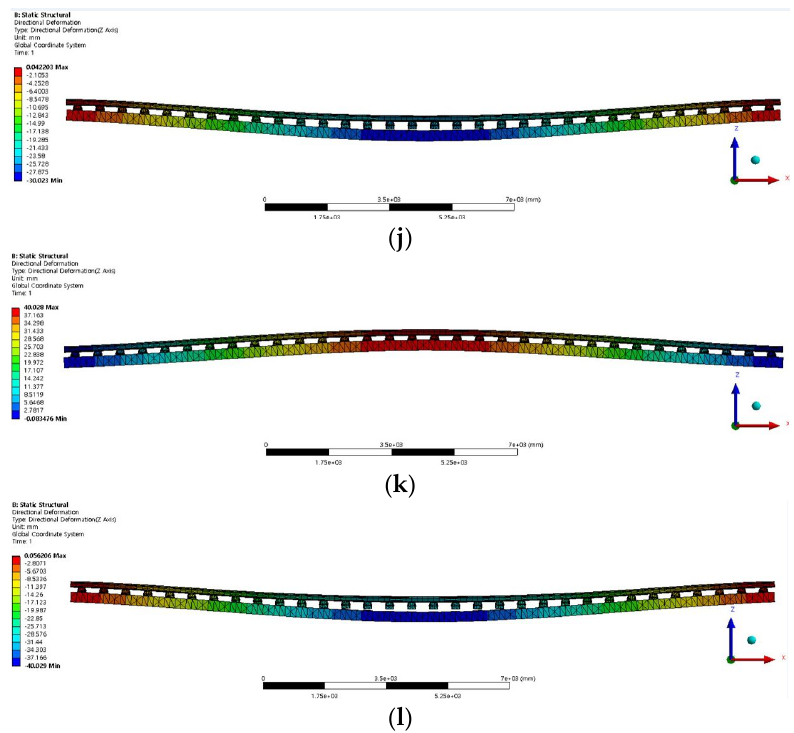
Figure 6. FE analysis results (displacement, z direction) for: ( a ) 5 mm uplift; ( b ) 5 mm subsidence; ( c ) 10 mm uplift; ( d ) 10 mm subsidence; ( e ) 20 mm uplift; ( f ) 20 mm subsidence; ( g ) 25 mm uplift; ( h ) 25 mm subsidence; ( i ) 30 mm uplift; ( j ) 30 mm subsidence; ( k ) 40 mm uplift; and ( l ) 40 mm subsidence.